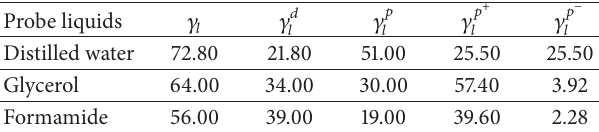
Table 2: Surface free energy components for the probe liquids (25 ∘ C).